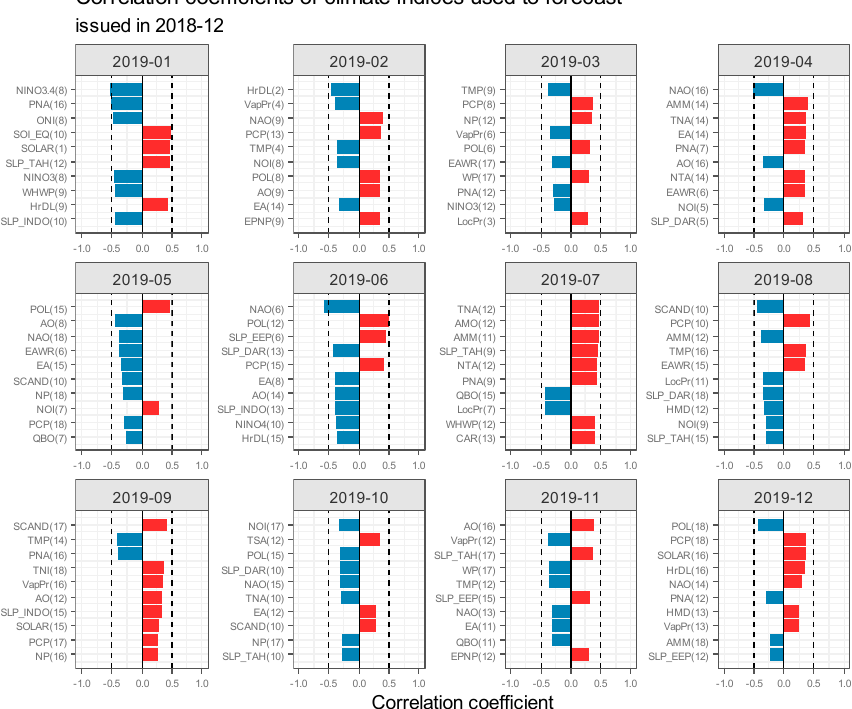
Figure 5. Correlations of the climate indices used for monthly forecasting models from January to December 2019.